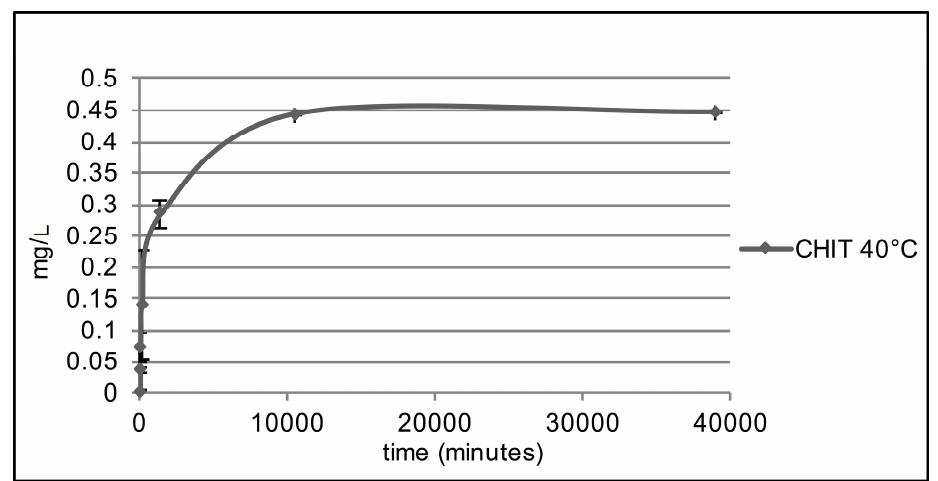
Figure 2. Release profiles of natamycin from chitosan film (CHIT) at 40 °C. Each dot represents the mean of the experimental data with an error bar of 2 replications.